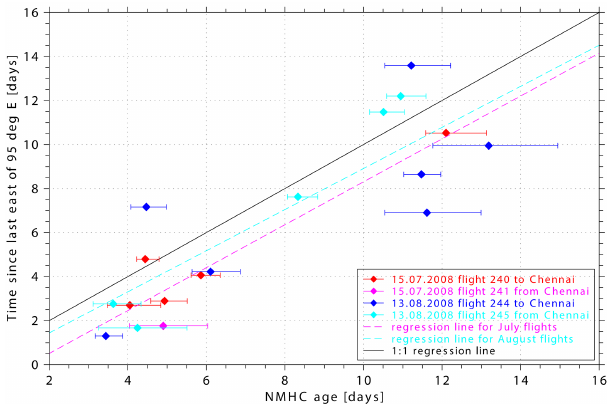
Figure 14. Photochemical age of pollutants in the air samples esti- mated from NMHC ratios (see Sect. 3.3.2 and Baker et al., 2011) versus relative latitude for the flights in July and the first two flights in August. Note the clustering of the chemically young sam- ples close to and south of the wind reversal ( (cid:49) lat < ∼ 3 ◦ ) and the older more chemically processed samples further north. Shown is the mean chemical age together with the minimum and maximum age determined from the propane / ethane, n -butane / ethane, and n - butane / propane ratios.